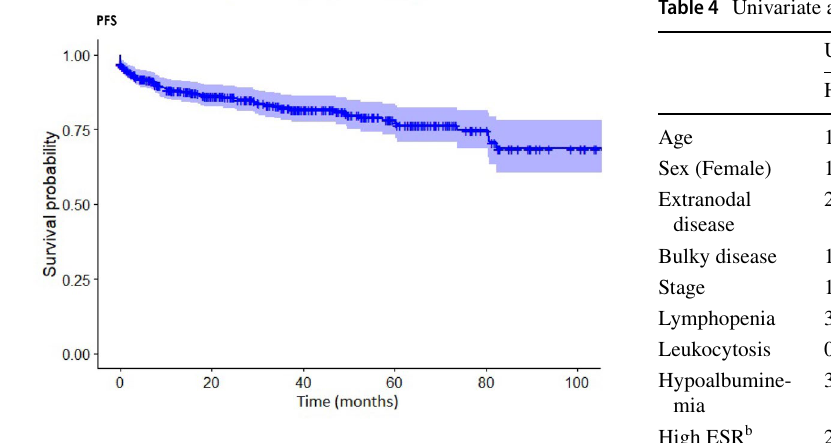
Fig. 2 Progression Free Survival in the complete cohort of patients